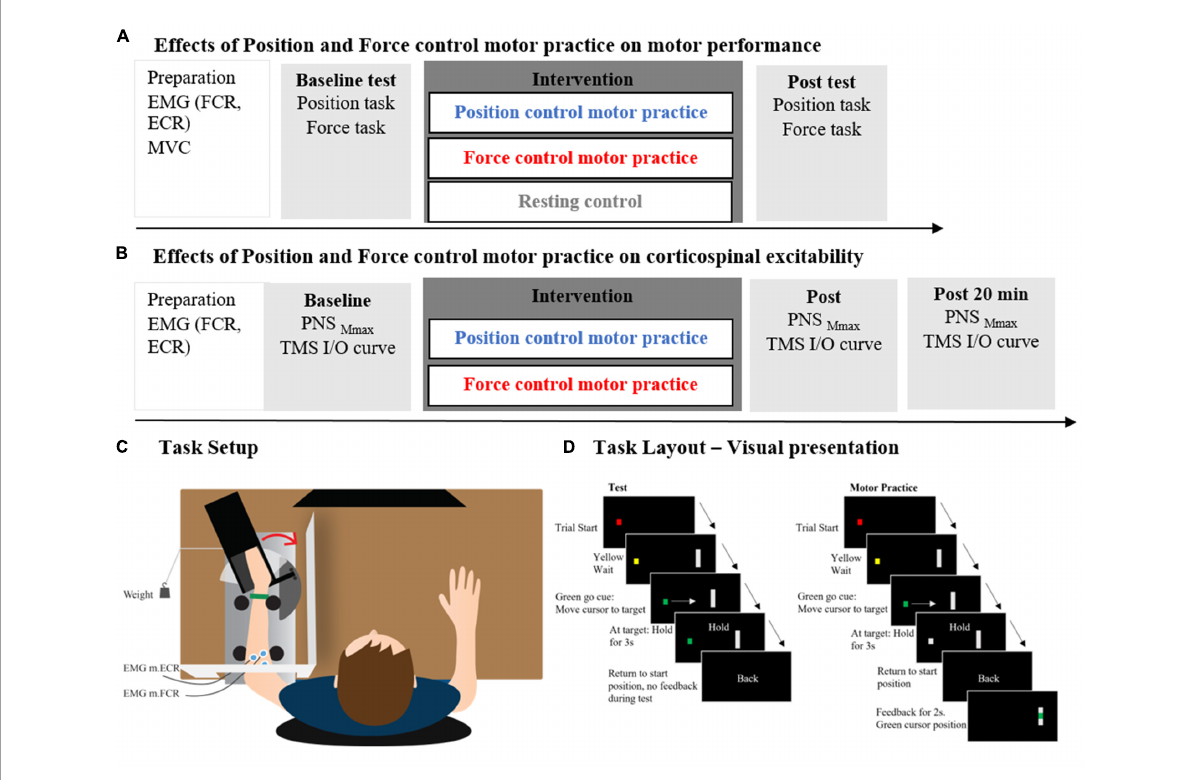
FIGURE1 Panel (A) depicts the experimental protocol of the main experiments including the two intervention groups: position control practice and force control practice and the control group. In panel (B) the experimental protocol of the supplementary experiments is depicted including the two intervention groups: position control practice and force control practice. The experimental setup is shown in panel (C) while the computerized task is shown in panel (D)